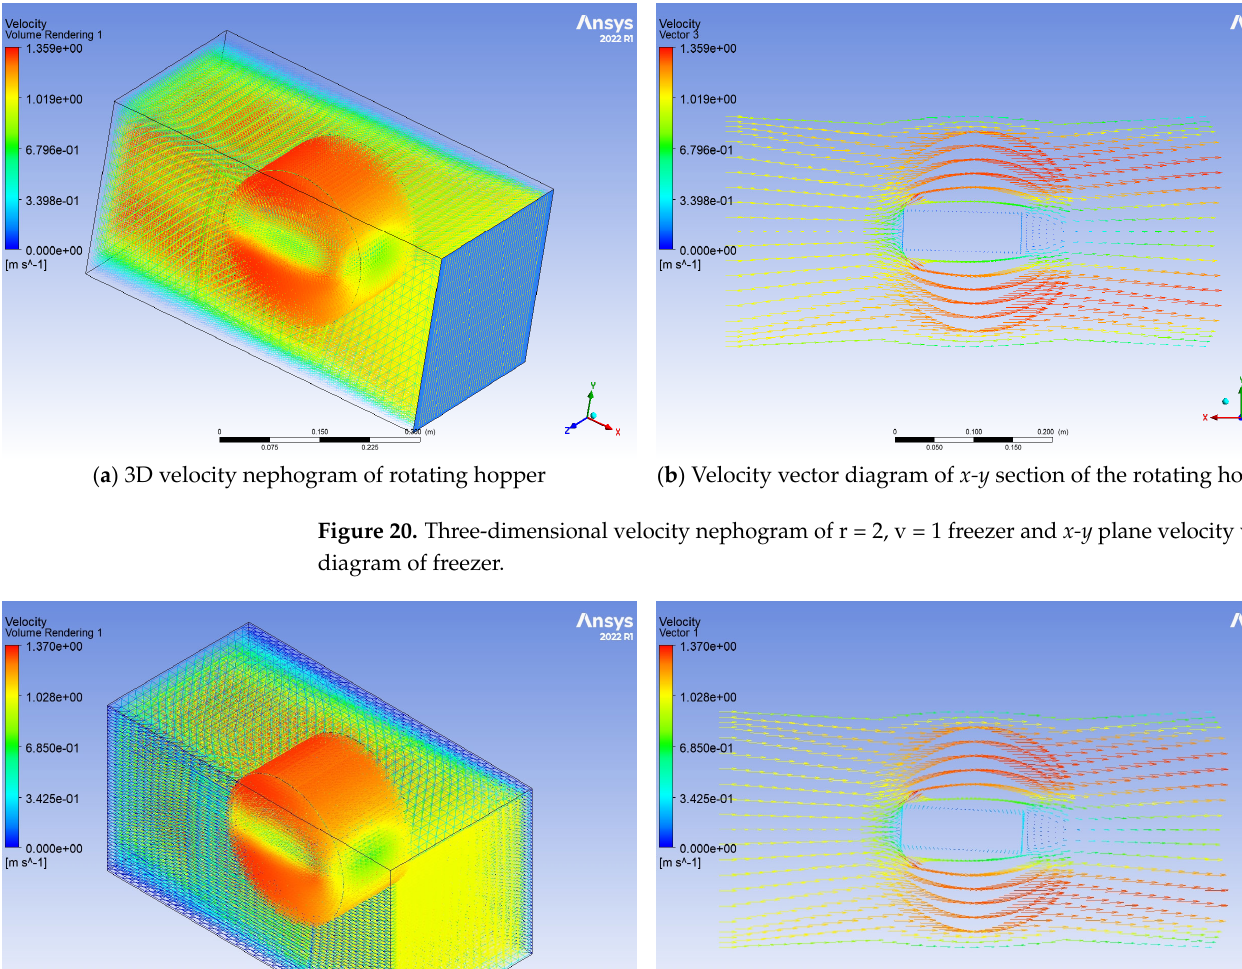
Figure 19. Three ‐ dimensional velocity nephogram of r = 0, v = 2 freezer and x ‐ y plane velocity vector diagram of freezer.